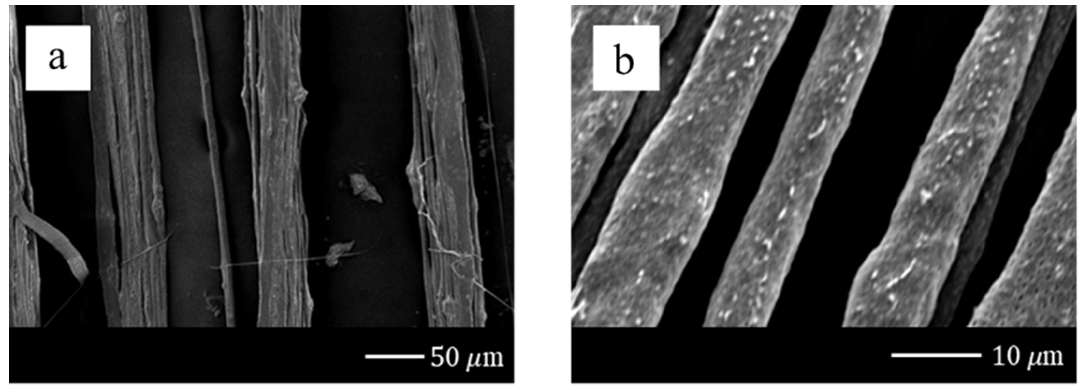
Figure 18. Diameter analysis of electrospinning fiber by ( a ) the stepper motor, ( b ) the servo motor.